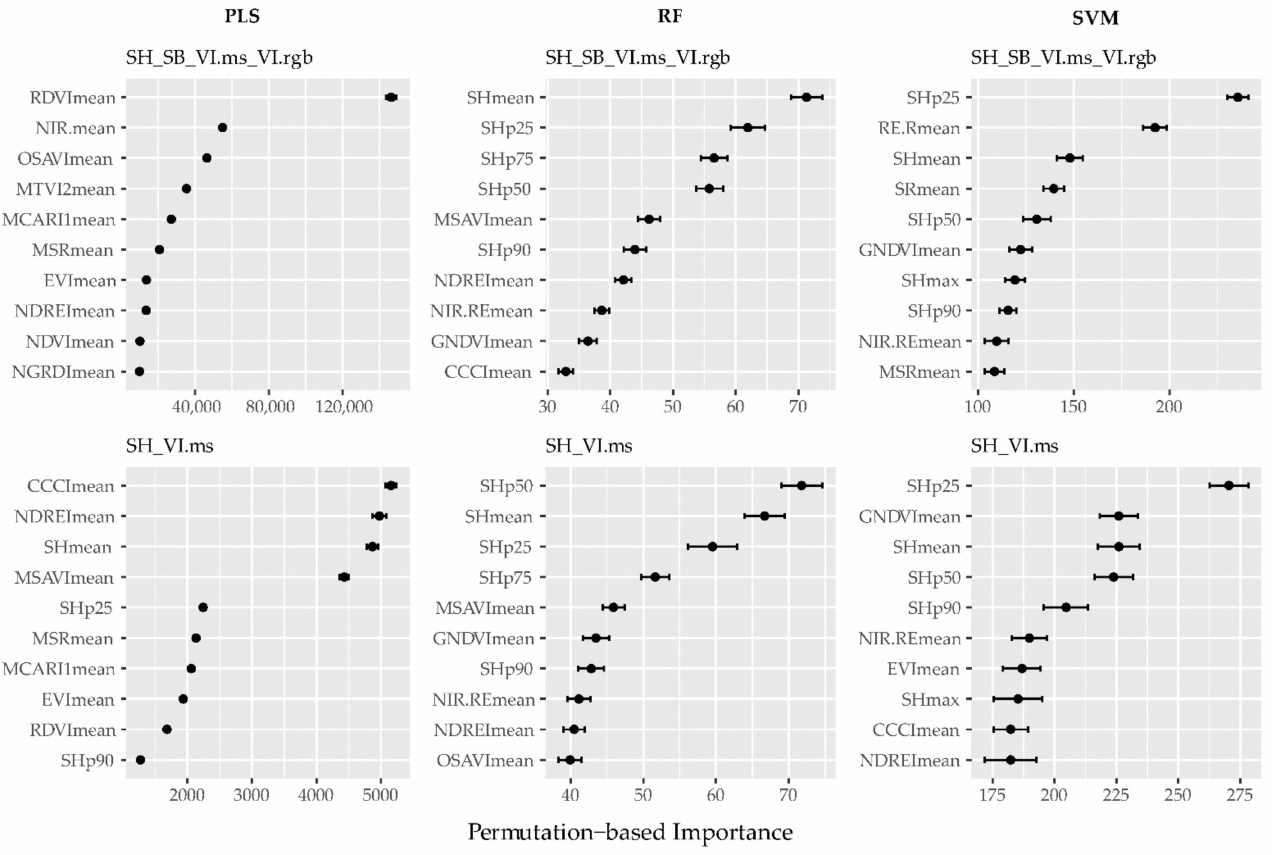
Figure 13. Variable importance plots of best models (10 most important variables shown) for DMY prediction. Variable importance is based on